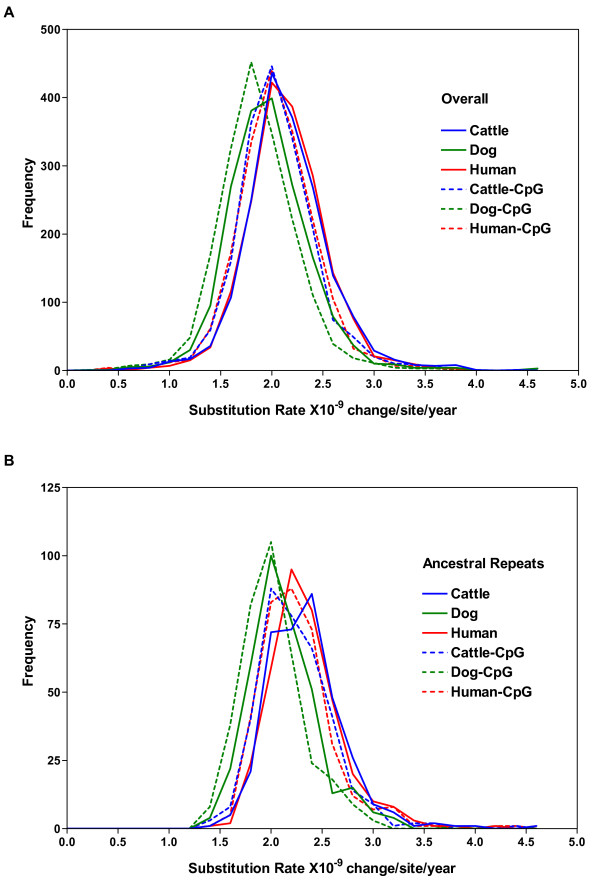
Distributions of Substitution Rates in Cattle, Dog and Human. (A) Histograms of the local substitution rates in aligned sequences (84 loci, 5.5 Mb aligned bases, 1,794 windows). (B) Histograms of the local substitution rates in aligned ancestral repeats (84 loci, 1.2 Mb aligned bases, 353 windows). All measures were computed in non-overlapping 3-kb sliding windows for cattle-dog-human multiple sequence alignments. These rates were calculated in multiple comparisons assuming branch times of the cattle, dog and human lineages from the LCA of cattle and dog of 83, 83 and 101 mya, respectively. Suboptimal alignments were excluded. The cattle branch: blue; the dog branch: green; and the human branch: red. The dashed lines were computed after removing CpG dinucleotides.